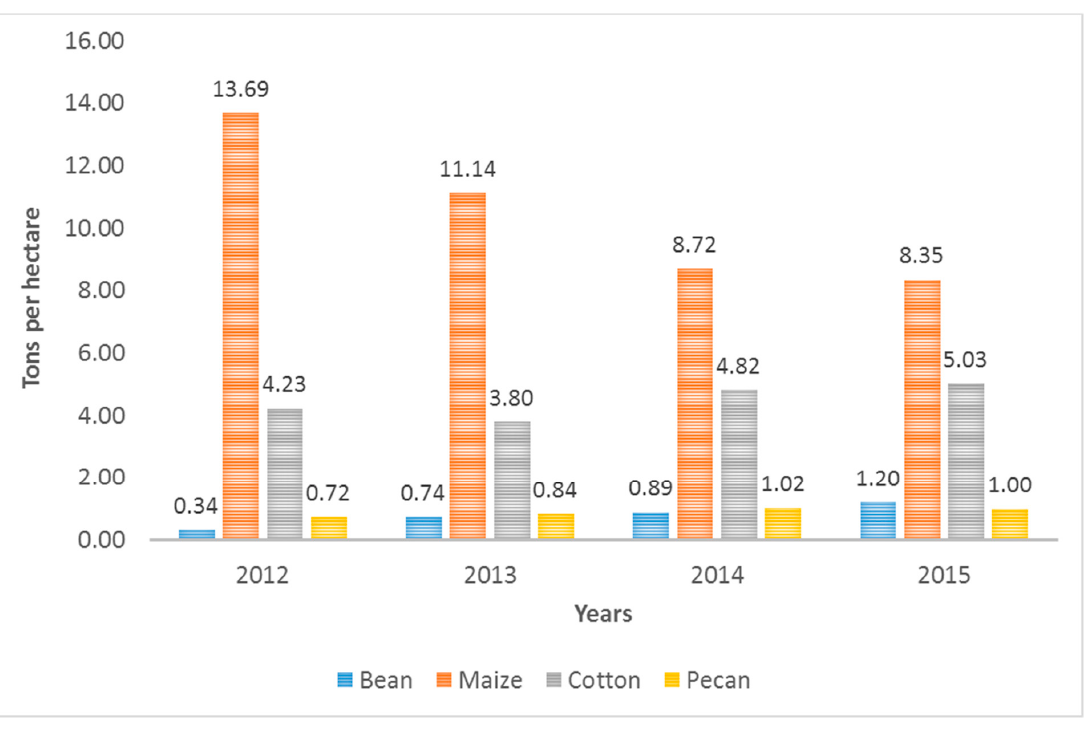
Figure 6. Main crop yields in key municipalities in the Rio del Carmen watershed from 2012–2015. Information obtained from INEGI, [68–71].